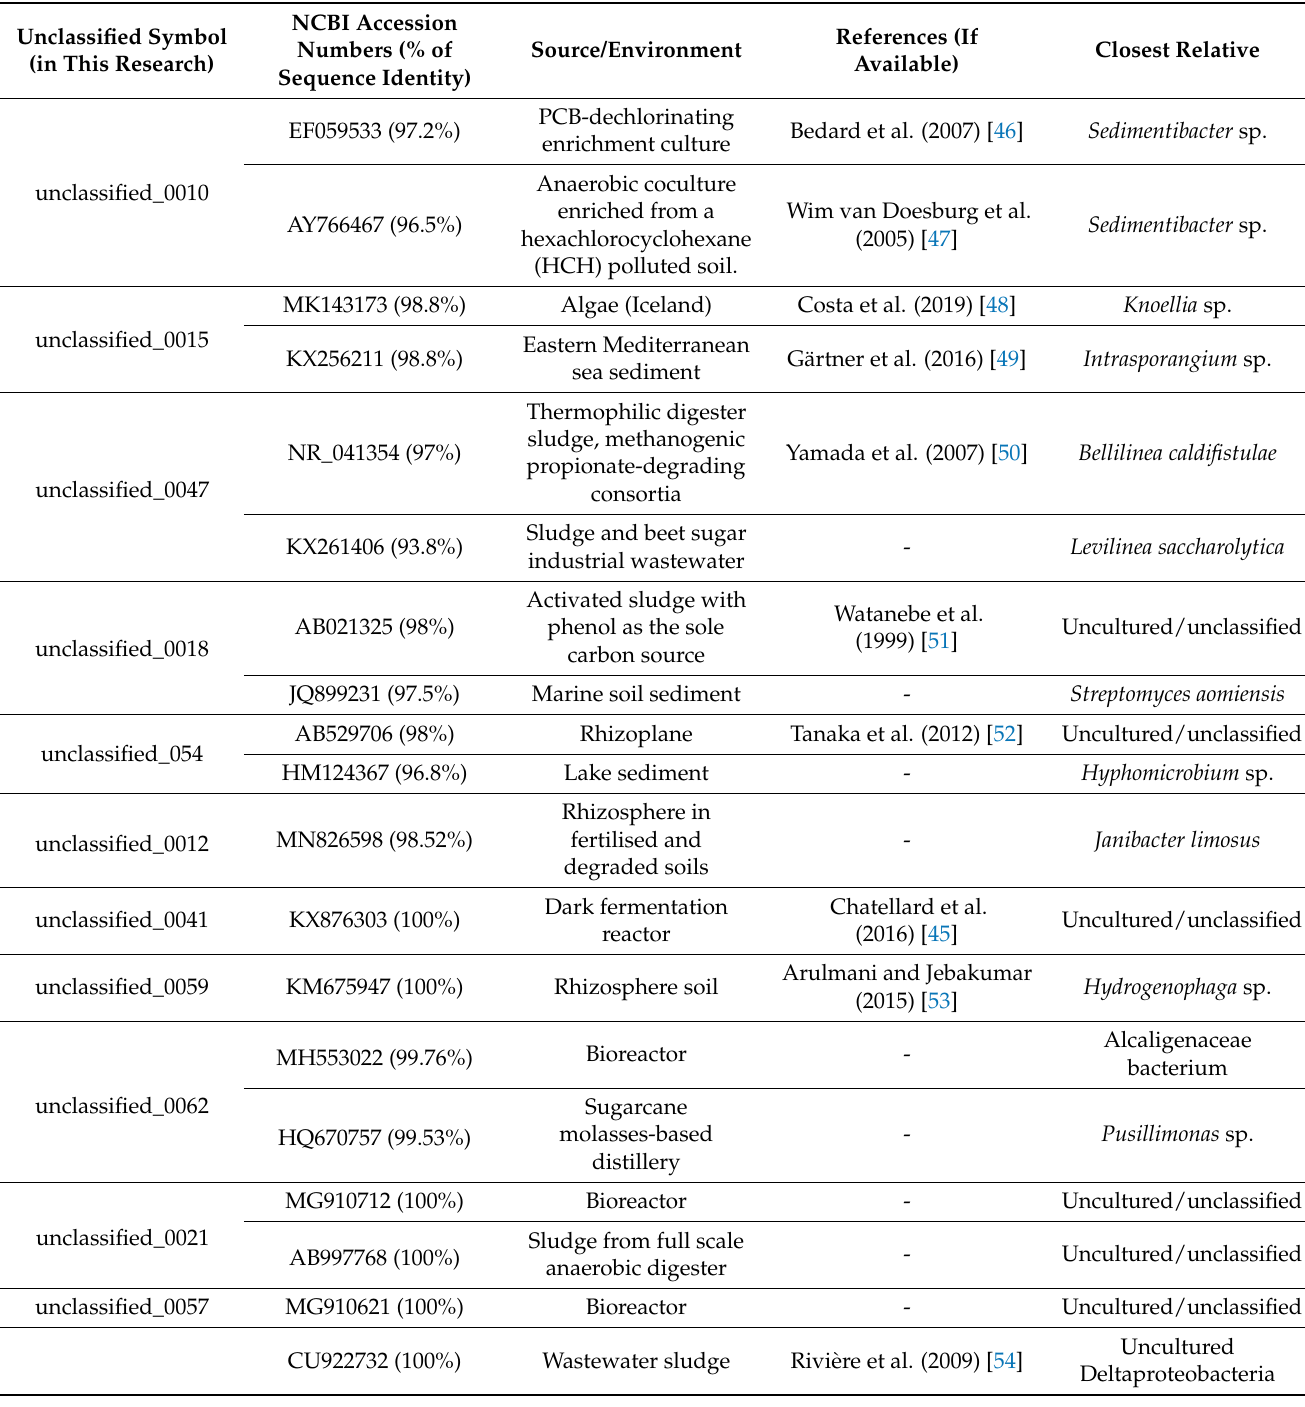
Table 2. The available information about selected, most abundant unclassified sequences, based on the NCBI